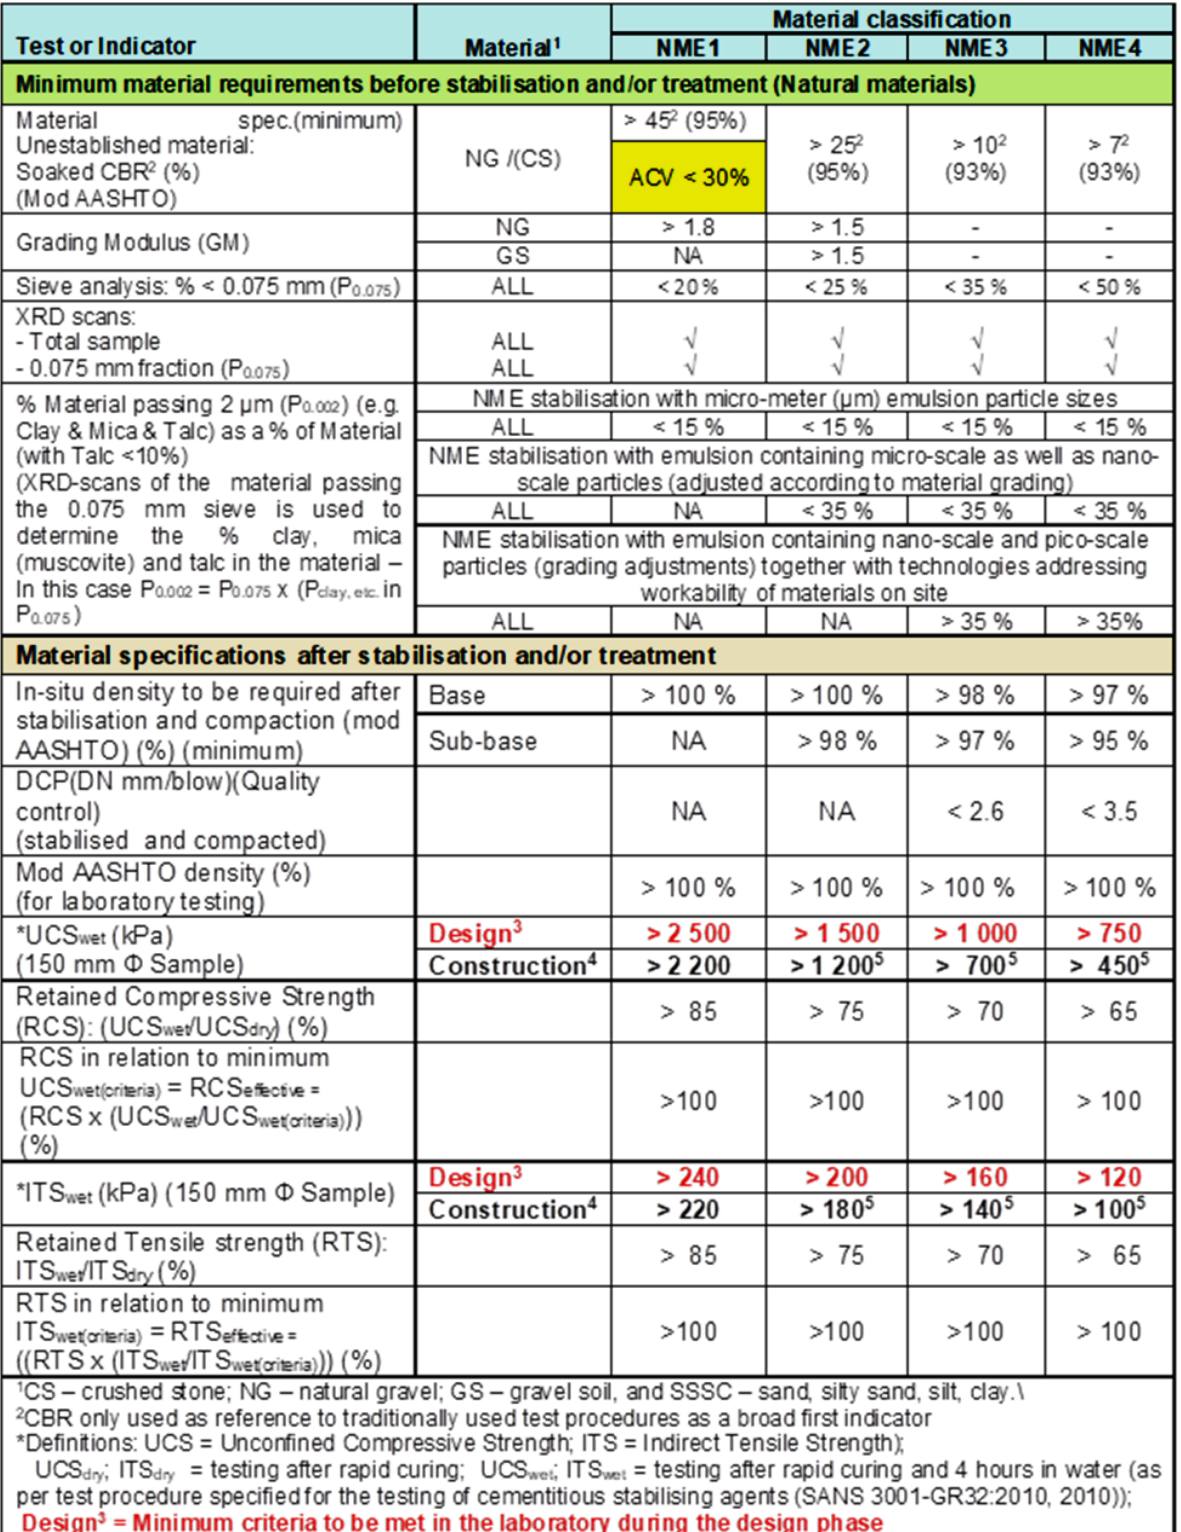
Figure 3. References [6,7]: Minimum recommended standard specifications for New-age (Nano) Modified (NME) stabilised materials, addressing four different classifications in terms of engineering requirements.